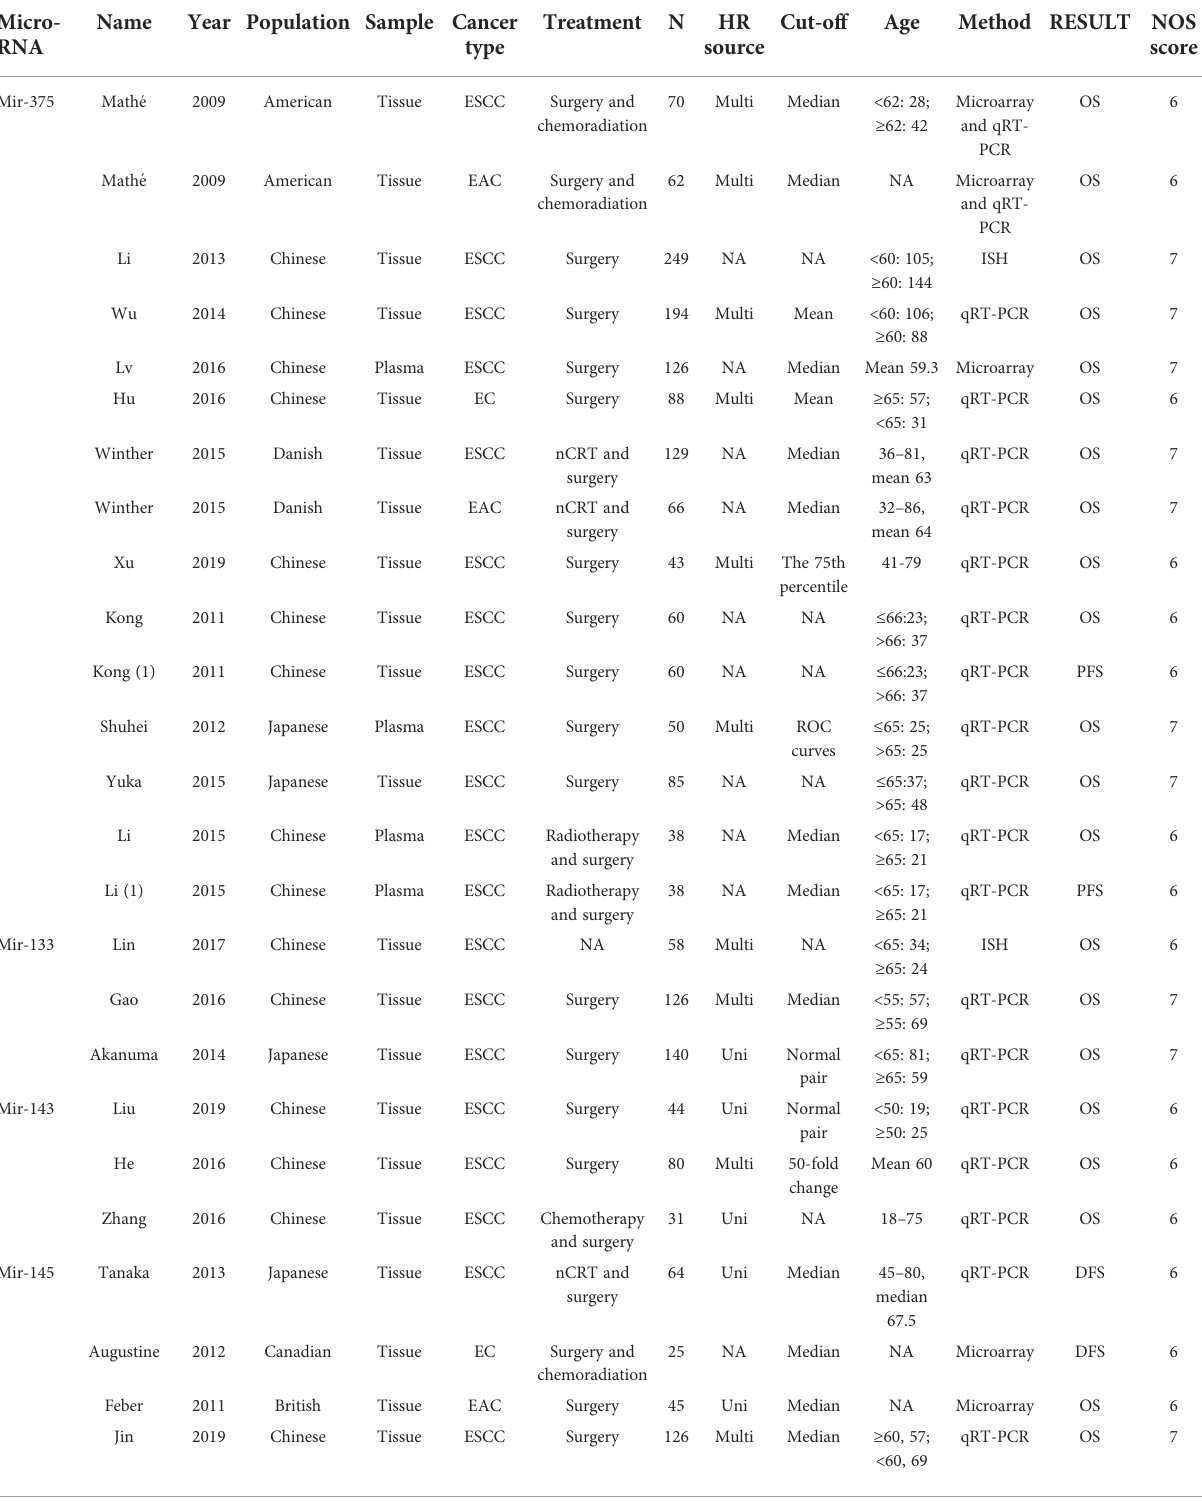
TABLE 1 The main characteristics of all included studies in this meta-analysis. Micro-